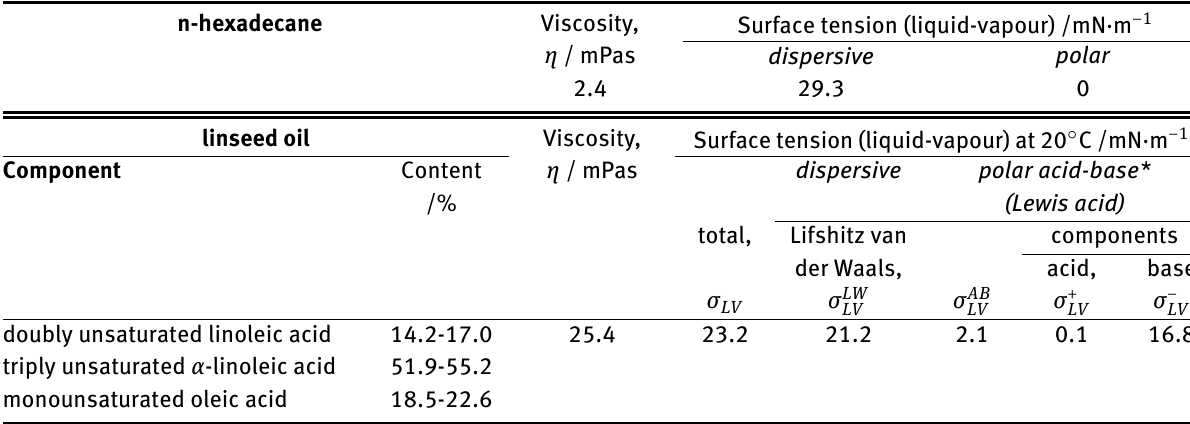
Table 1: n-hexadecane and linseed oil typical composition and properties [12,